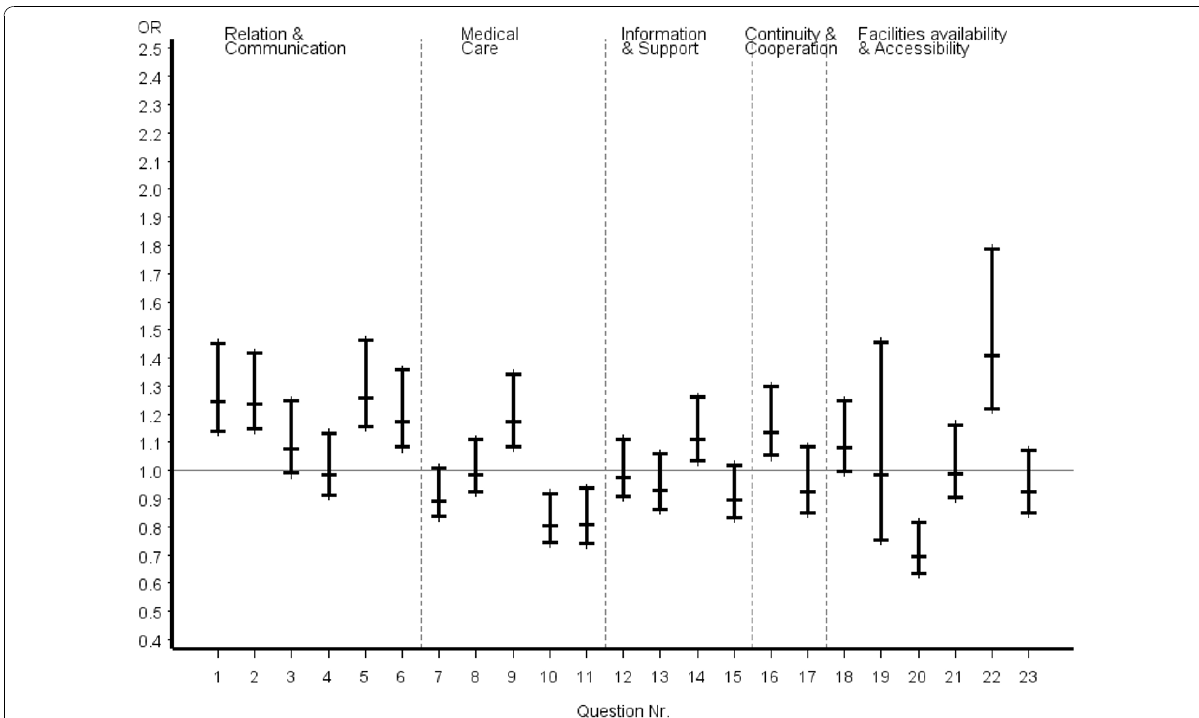
Figure 3 ..Europep questionnaire, odds ratios of most favourable answer option (certified CAM vs. COM) Stratified analysis of patients with non-severe conditions (patient rated) . Errorbars denote 95% confidence intervals of odds ratios